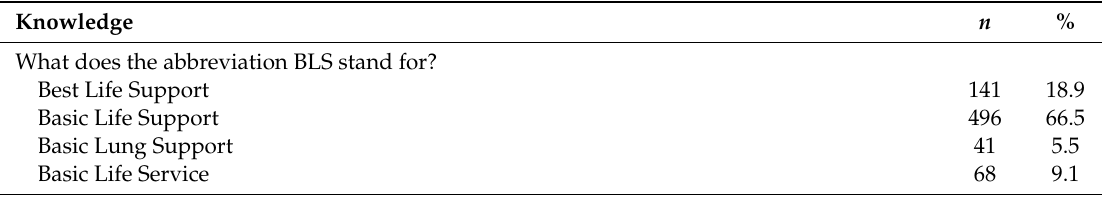
Table 2. Knowledge and practice about basic life support among nursing student